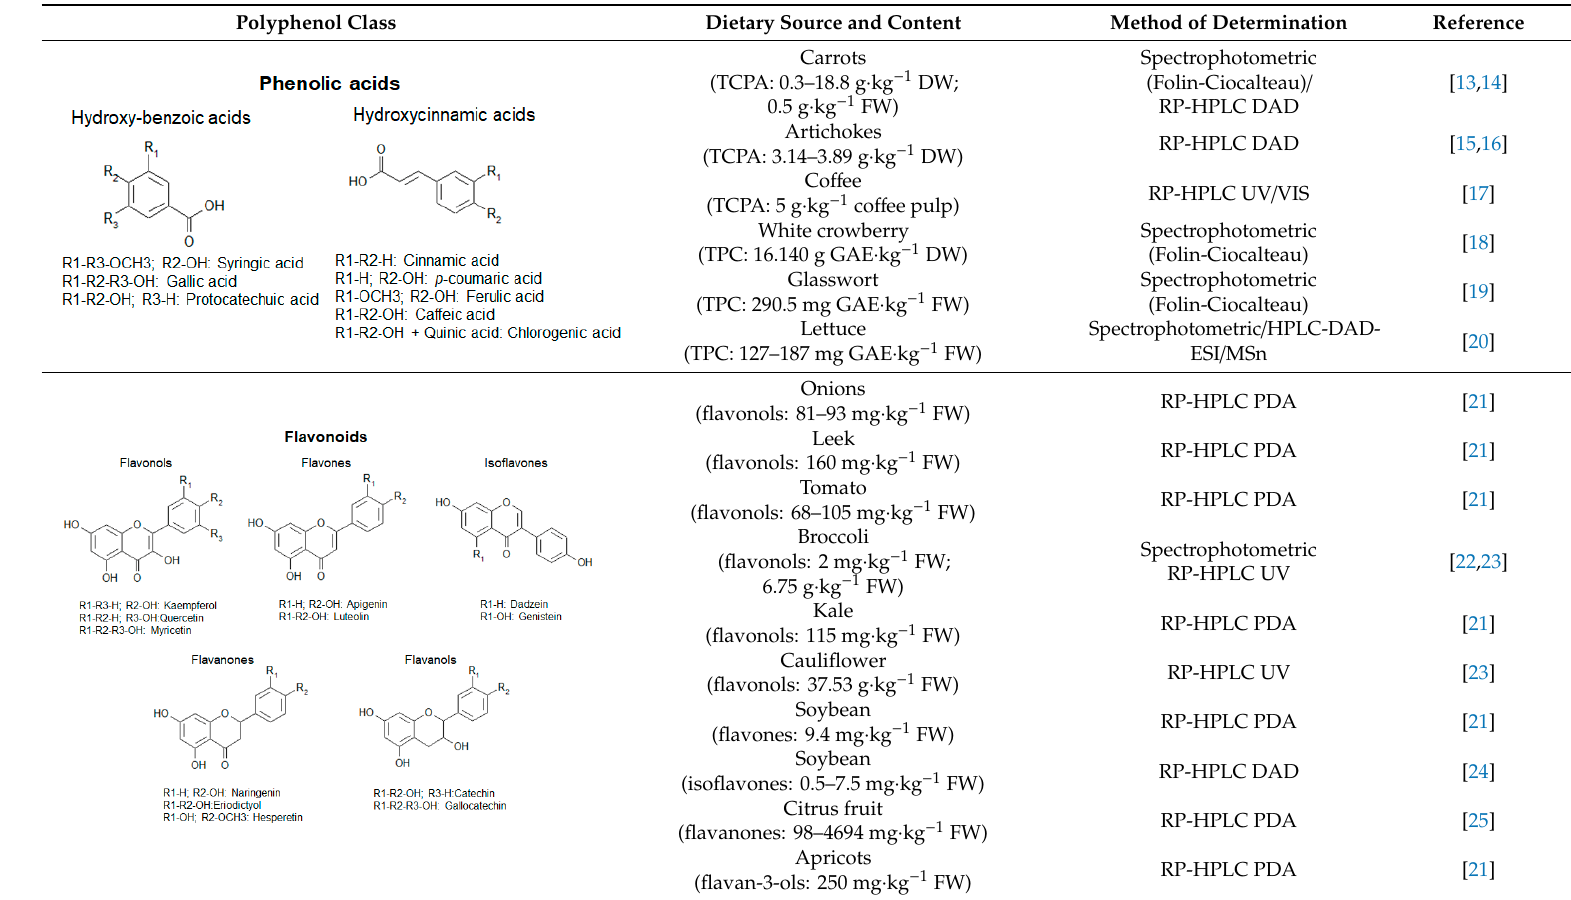
Table 1. Main polyphenol classes, content in dietary sources and detection methods. TCPA: total content of phenolic acids; TCF: total content of flavonoids; TCA, total content of anthocyanidins; TCS: total content of stilbenes; TPC: total polyphenol content.